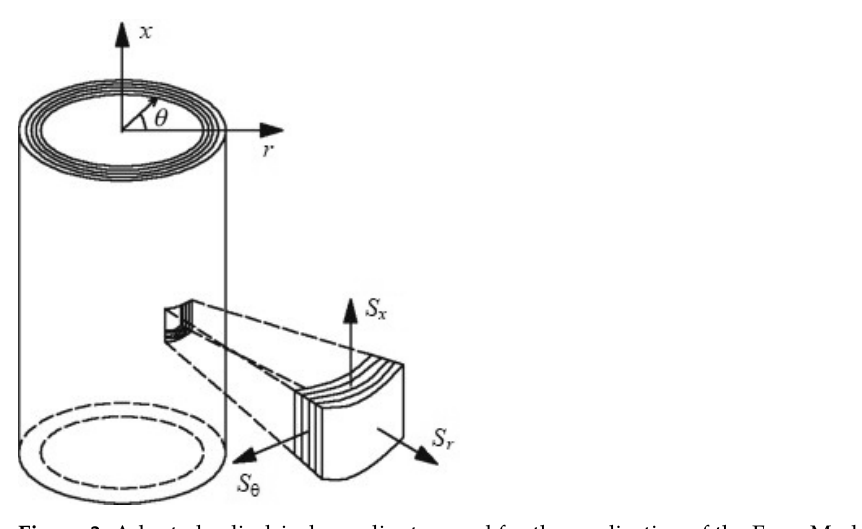
Figure 3. Adapted cylindrical coordinates used for the application of the Fung Model to a tubular section of the